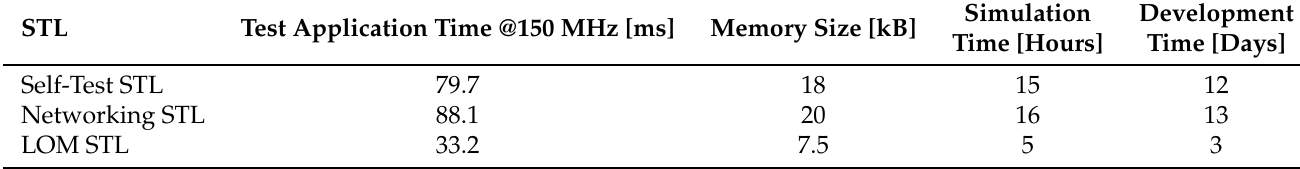
Table 1. Main figures about the developed